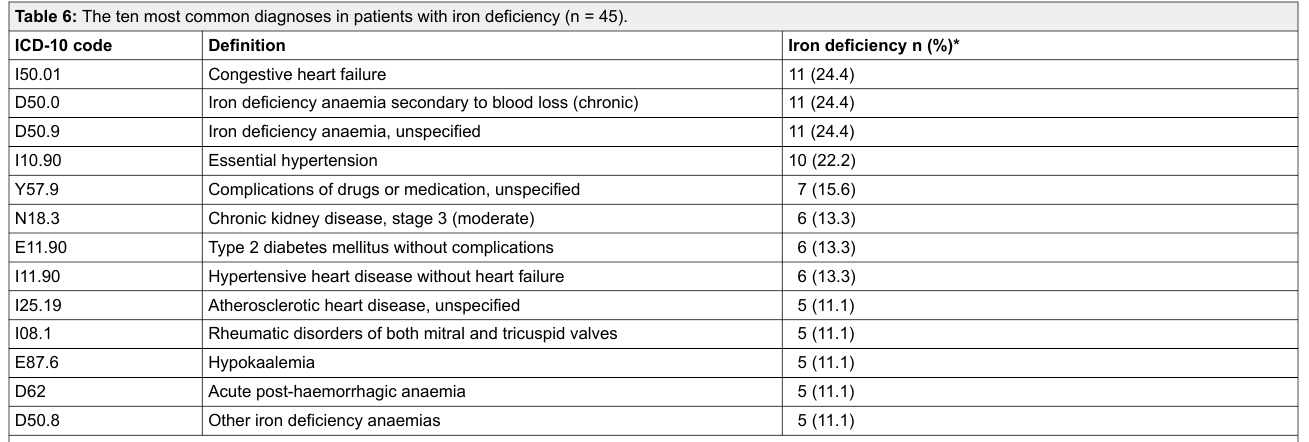
Table 6: The ten most common diagnoses in patients with iron deficiency (n = 45). ICD-10